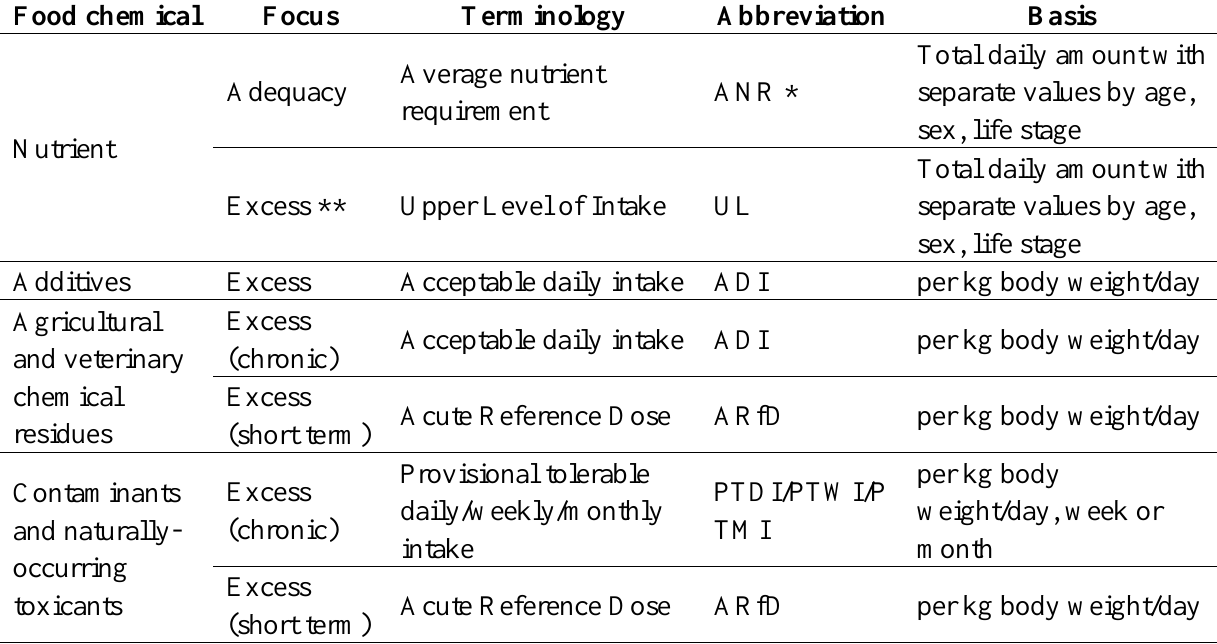
Table 2. Reference health standards of food chemicals for assessing human